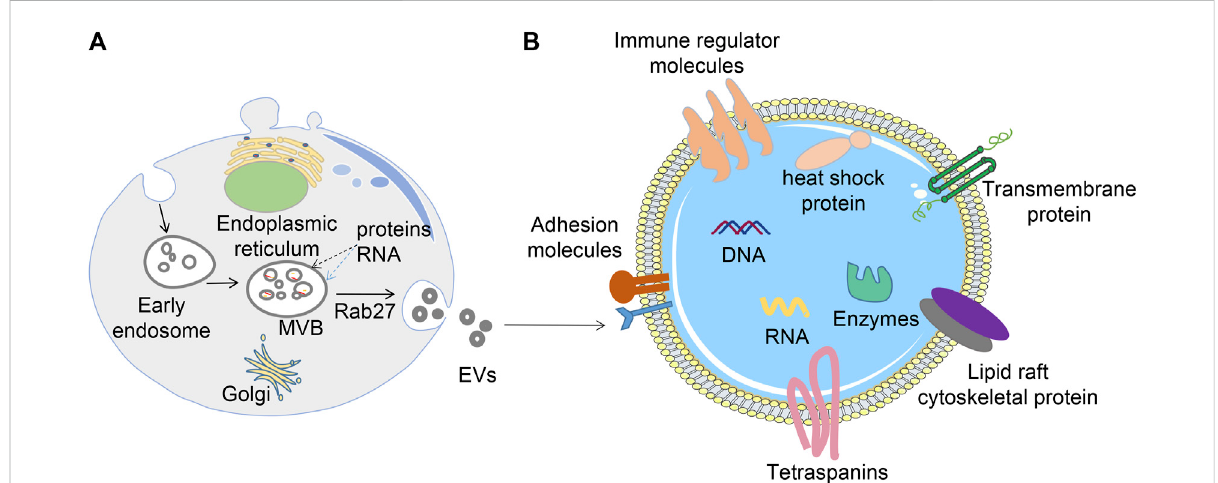
FIGURE 1 Biogenesis, release, and structure of EVs. (A) EVs are formed via the endosomal pathway and released upon fusion of MVBs with the plasma membrane; (B) EVs have a phospholipid bilayer membrane structure, the surface of the membrane contains many proteins, whereas the interior contains nucleic acids, proteins, and various